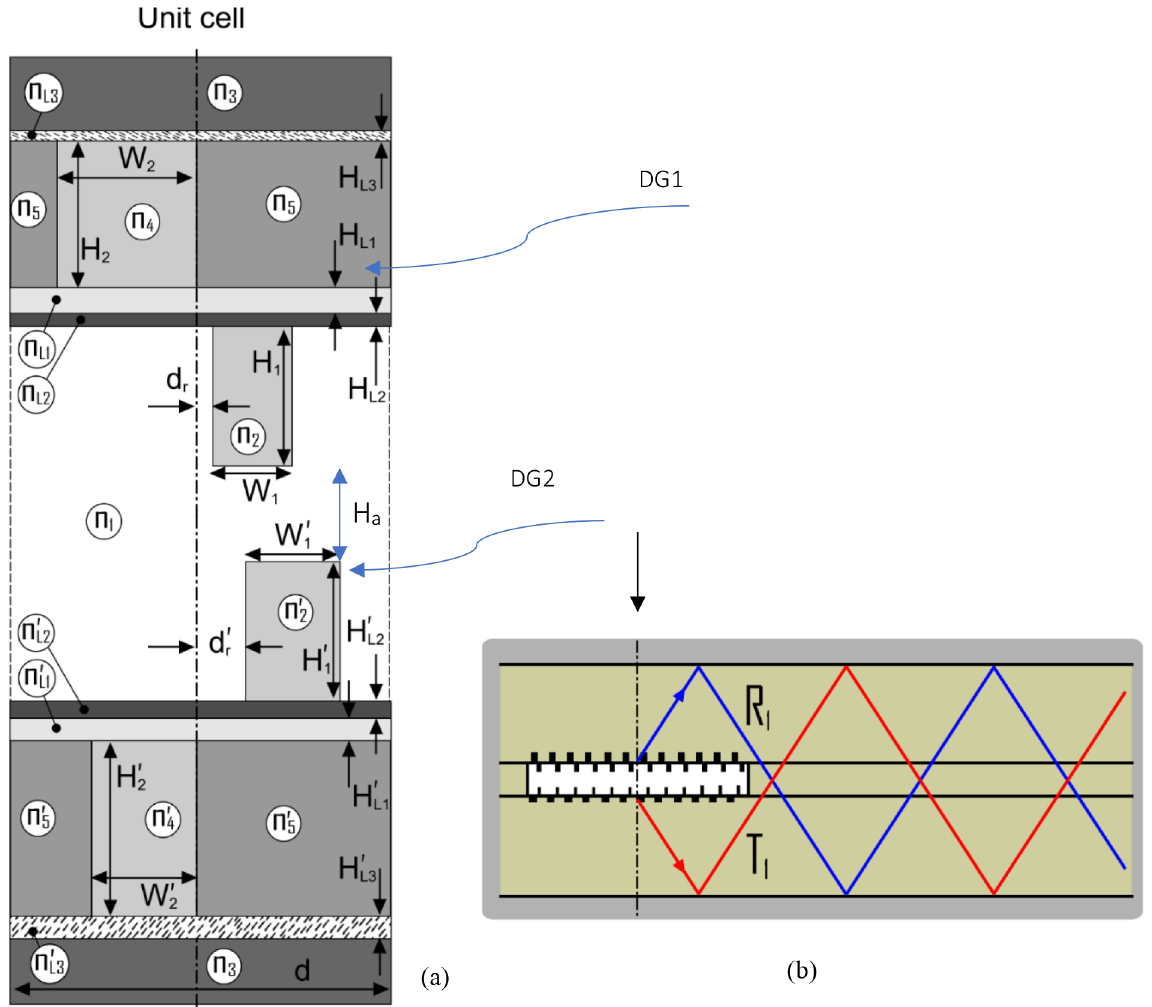
Fig. 8. (a) Cross-section views of the unit cell of the metagrating. (b) Schematic side view illustrating geometry and distribution of diffraction order propagation of an example